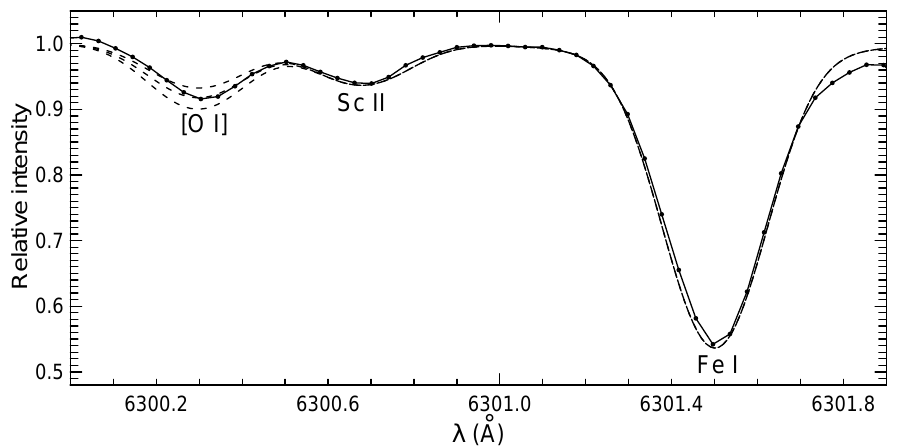
Fig. 4. Synthetic spectrum fit to the forbidden [O i ] line at 6300 ˚A for (cid:21) And. The observed spectrum is shown as the solid line joining the dots. The dashed lines denote the synthetic spectra with [O/Fe] = 0.35, 0.45 and 0.55 dex downward.